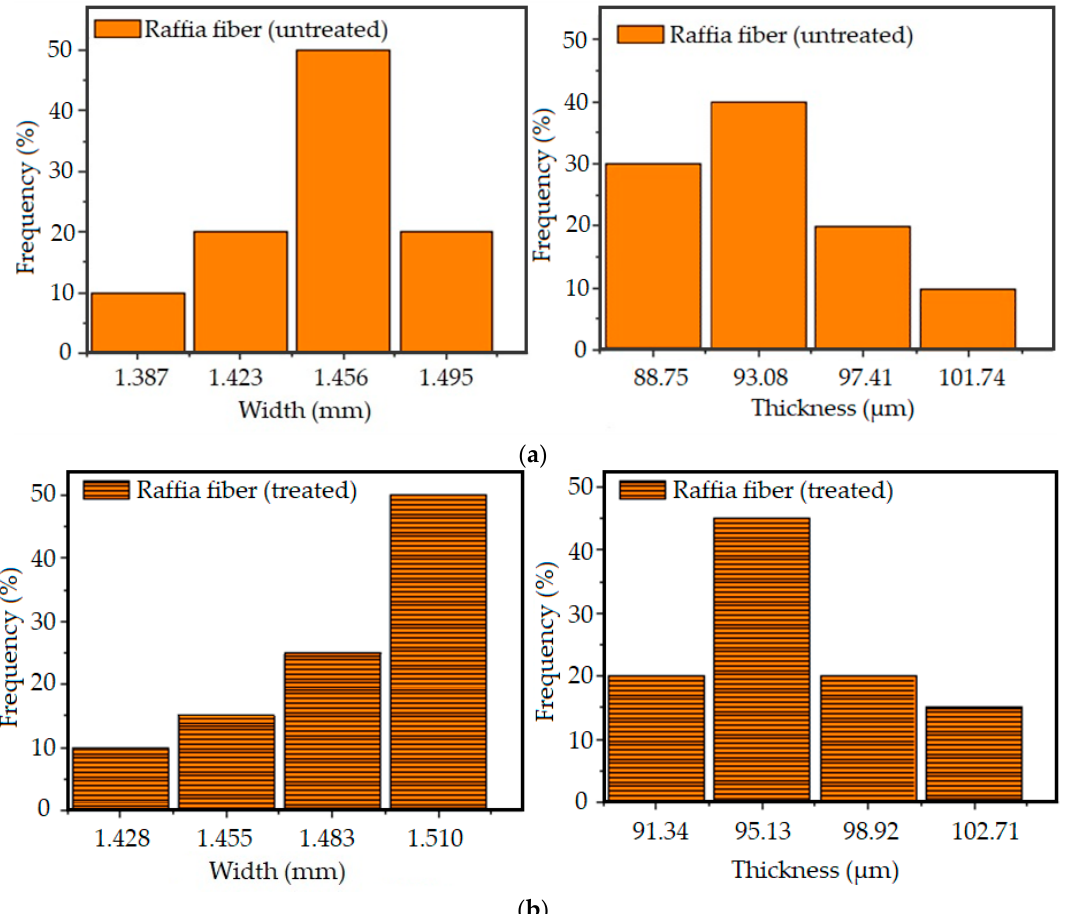
Figure 5. Frequency distribution of the widths and thicknesses of raffia fibers: ( a ) untreated; and ( b ) alkali-treated.